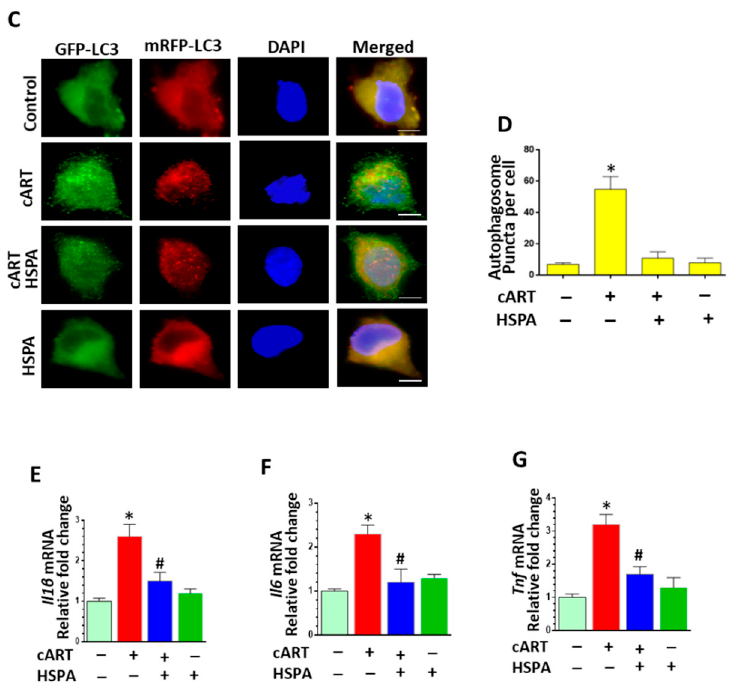
Figure 6. HSPA overexpression abrogated cART-mediated autophagy dysregulation and microglia activation. ( A , B ) Representative western blots and bar graphs showing overexpression of HSPA in rPMs reversed cART-mediated upregulation of autophagy markers MAP1LC3B and SQSTM1. ( C , D ) HSPA-overexpressing rPMs were seeded into 12-well plates followed with the transfection of tandem fluorescent-tagged MAP1LC3B plasmid. Then, cells were exposed to various treatments for another 24 h and fluorescent intensity was assessed by confocal microscopy. HSPA reversed cART-